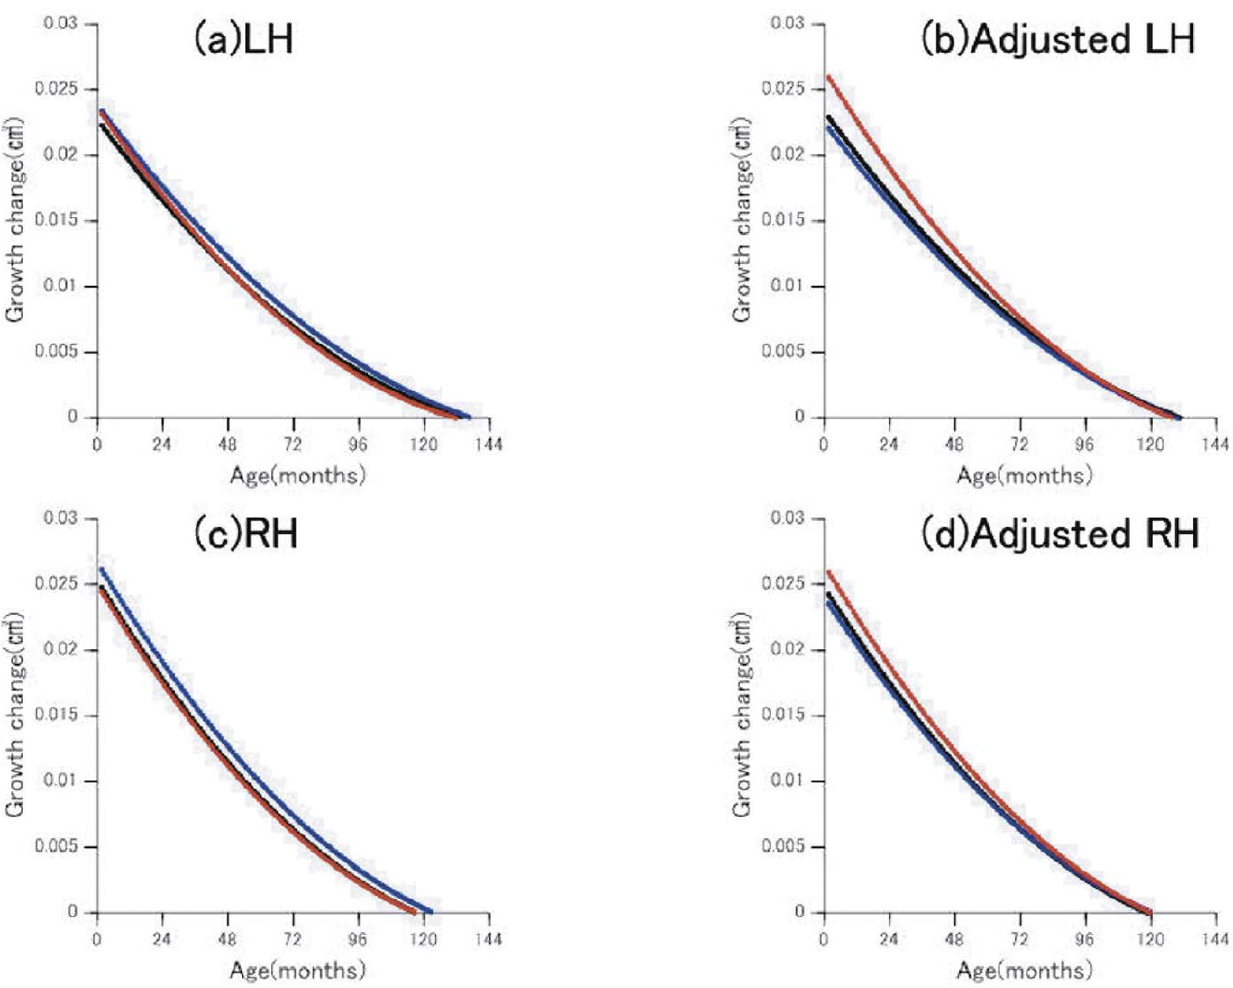
Figure 5. Rate of growth change in hippocampal volumes. (a); LH: left hippocampus, (b);left hippocampus adjusted by ICV, (c); RH: right hippocampus, (d);right hippocampus adjusted by ICV. The rates of monthly volume changes in the right and left hippocampus. Positive values indicate increasing volume. The point of intersection on the x-axis represents the age of local maximal volume. Black line: whole group, blue line: males, red line: females.